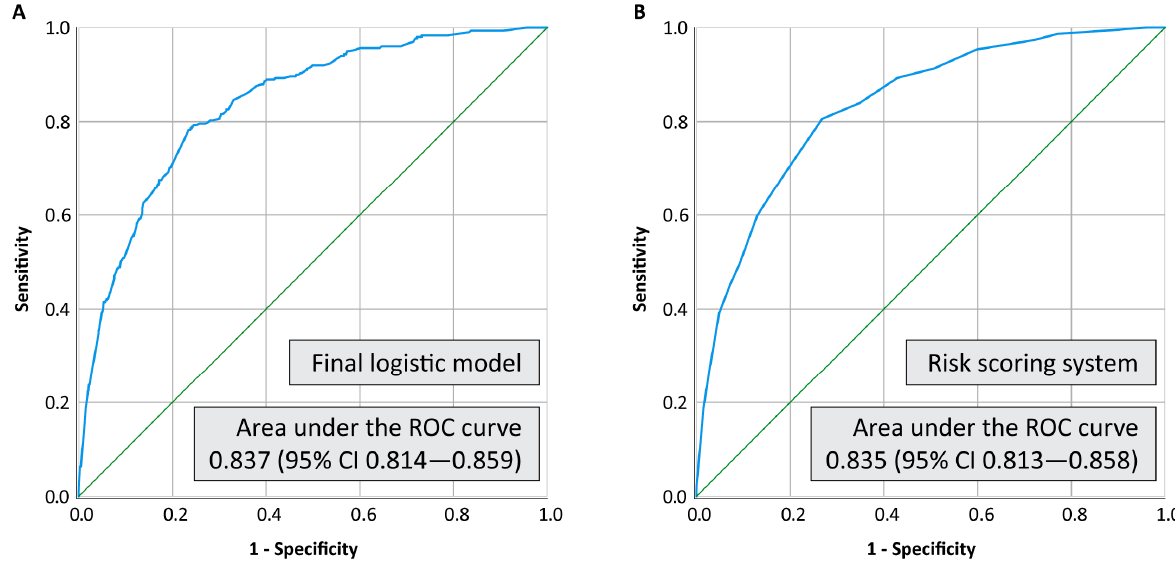
Figure 2. Areas under the ROC curve for the final logistic model ( A ) and the risk scoring system ( B ).